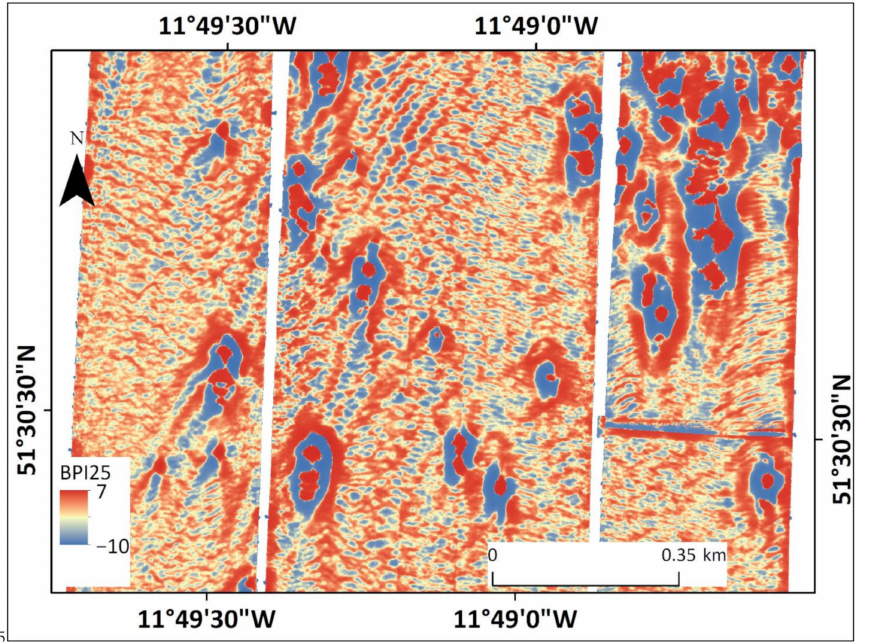
Figure 10. BPI25 bathymetry derivative layer displaying the intense scouring as negative topographic features surrounding the CWC mounds forming a comet and tail